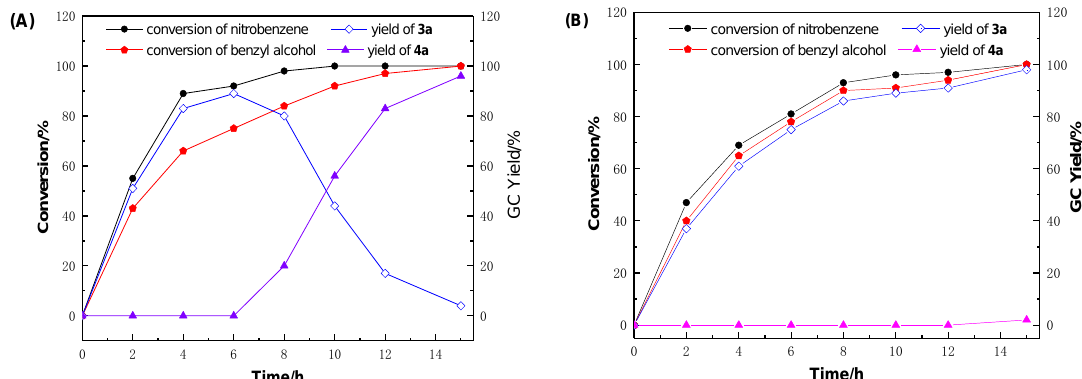
Figure 2. Kinetics of Amine 4a and Imine 3a. Reaction conditions: ( A ) nitrobenzene (0.2 mmol), benzyl alcohol (0.8 mmol), CoO x @NC-800 (10 mol%), t BuOK (0.8 mmol), 120 °C, toluene (5 mL), 15 h; ( B ) nitrobenzene (0.2 mmol), benzyl alcohol (0.6 mmol), CoO x @NC-800 (10 mol%), t BuOK (0.6 mmol), 120 °C, toluene (5 mL), 15 h.